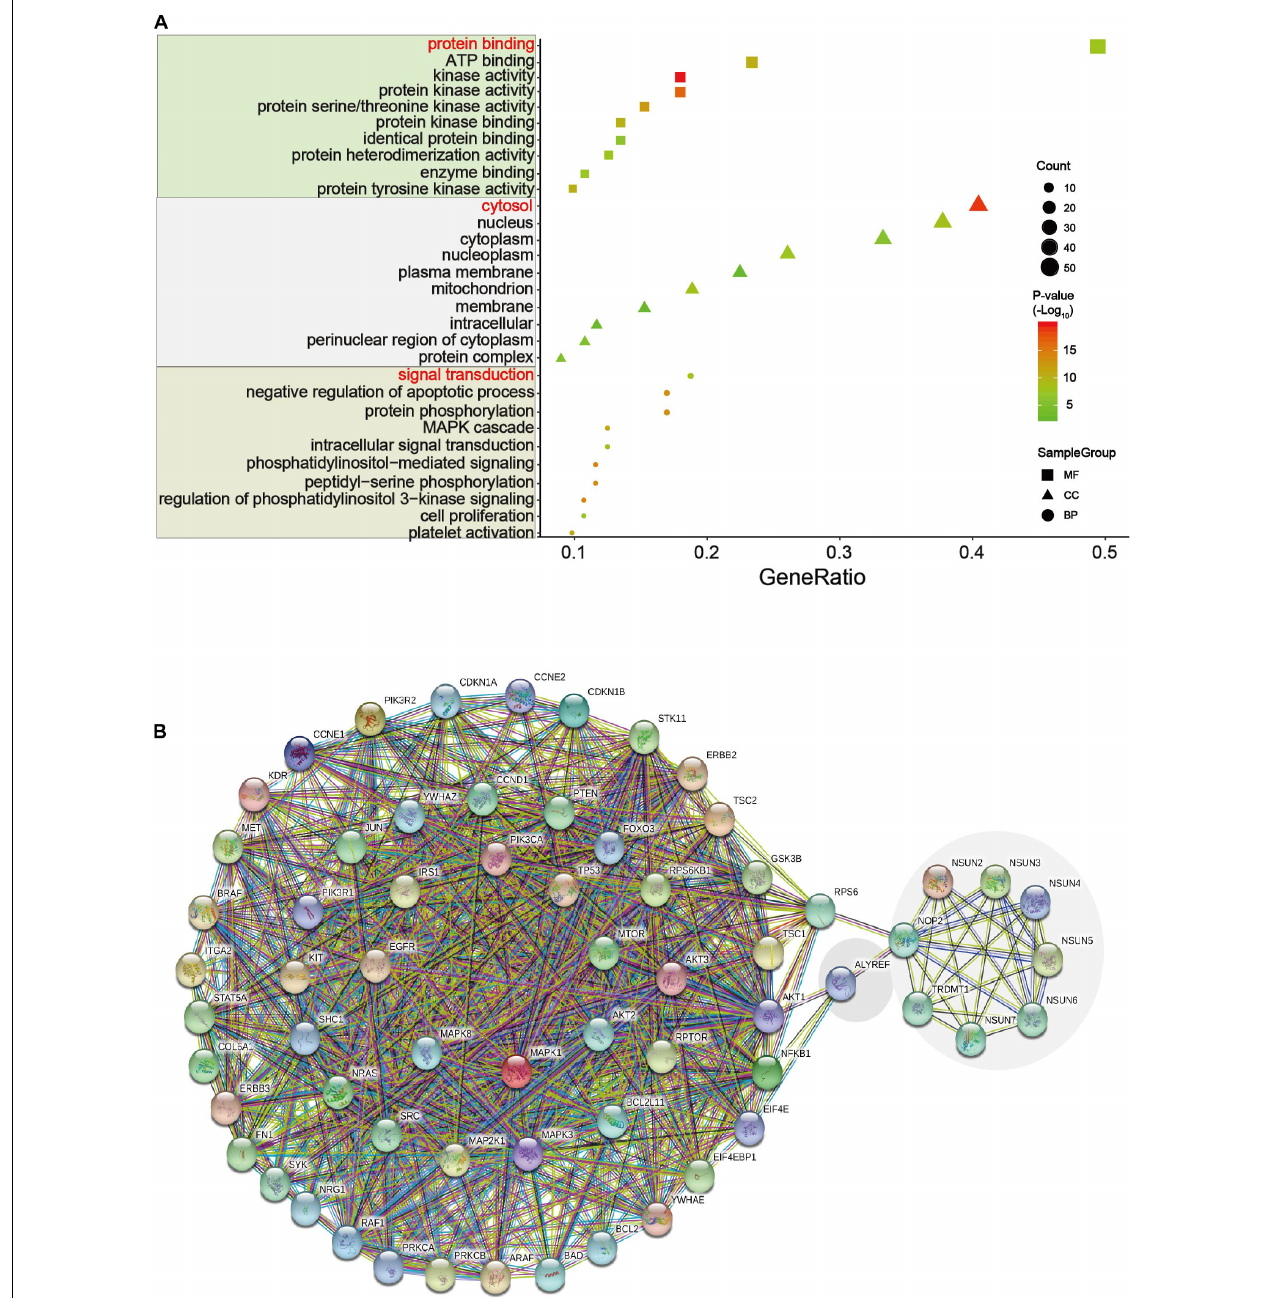
FIGURE 7 | GO and network analysis of proteins in two important pathways. (A) Gene Ontology (GO) enrichment analysis of the m 5 C RNA methylation modification was analyzed via DAVID. GO contains biological processes, cell components, and molecular functions. In this picture, count represents the number of genes contained in the GO term. The count and P values were considered together to obtain important metabolic process. Three important metabolic processes are affected by m 5 C RNA methylation, including protein binding, cytosol, and signal transduction. (B) Multicenter protein–protein interaction (PPI) network between m 5 C regulatory proteins and differential proteins in the ErbB and PI3K–Akt pathways in the STRING